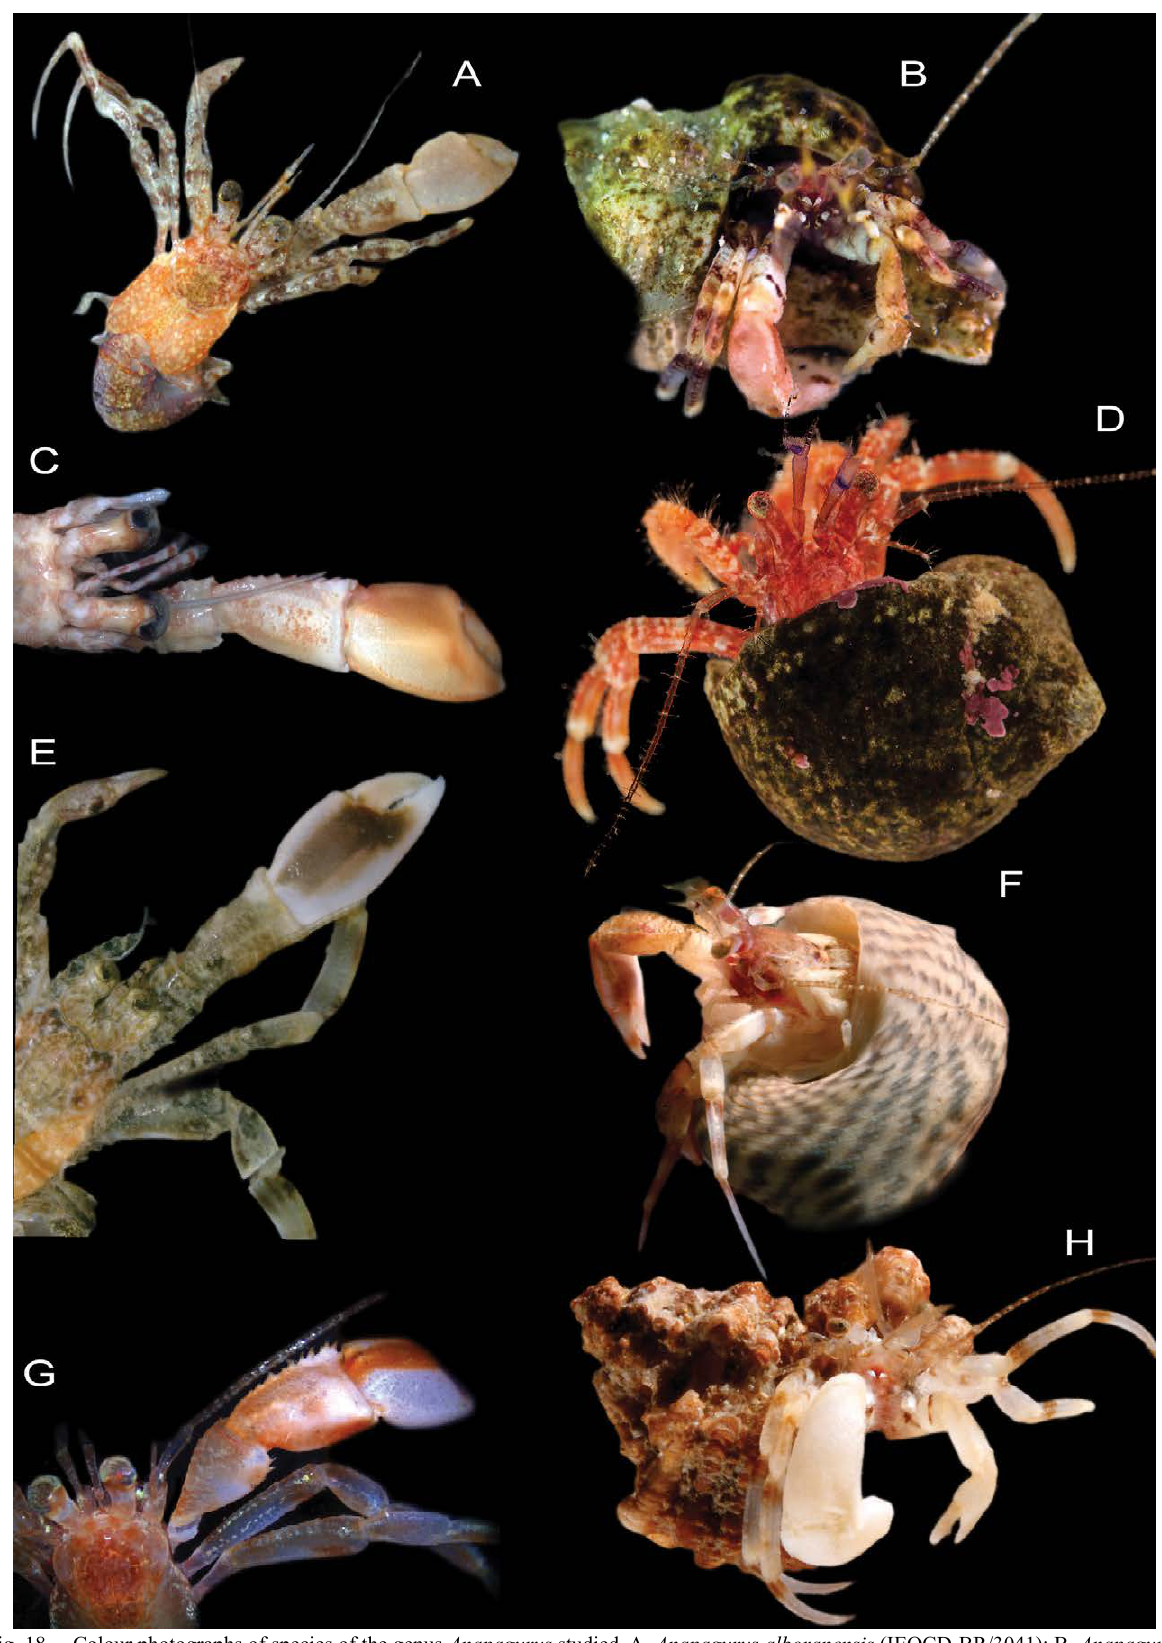
Fig. 18. – Colour photographs of species of the genus Anapagurus studied. A, Anapagurus alboranensis (IEOCD-BR/3041); B, Anapagurus hyndmanni (IEOCD-BR/3069); C, Anapagurus breviaculeatus (IEOCD-BR/3048); D, Anapagurus chiroacanthus (© Fredrik Pleijel); E, Anapagurus petiti (IEOCD-BR/313); F, Anapacurus pusillus (IEOCD-BR/316); G, Anapagurus laevis (IEOCD-BR/3096); H, Anapagurus curvidactylus (© Jacinto